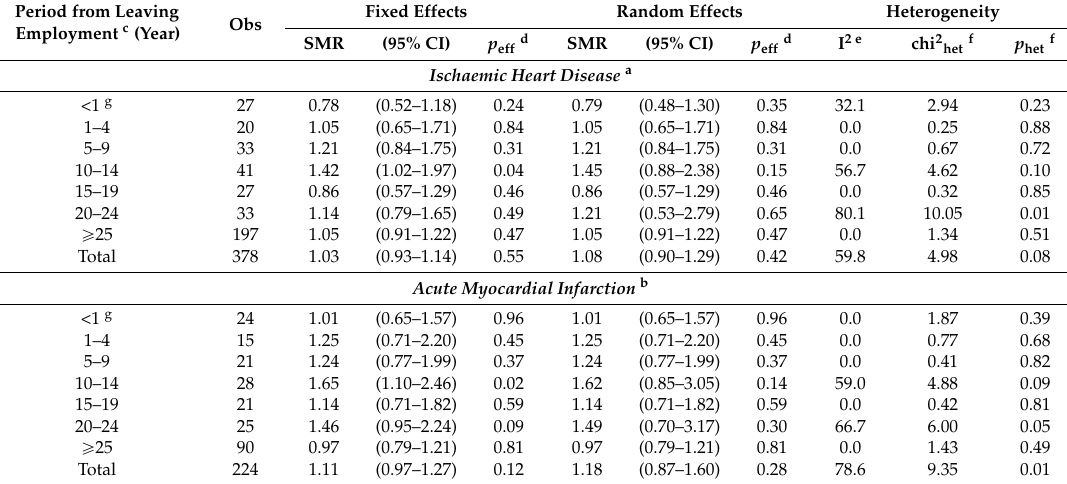
Table 8. Meta analyses of standardised mortality ratios (SMRs) for cardiac a,b mortality based on national rates by period from leaving employment, in carbon black production workers of three inception cohorts combined (US: follow-up ě 1979, UK,